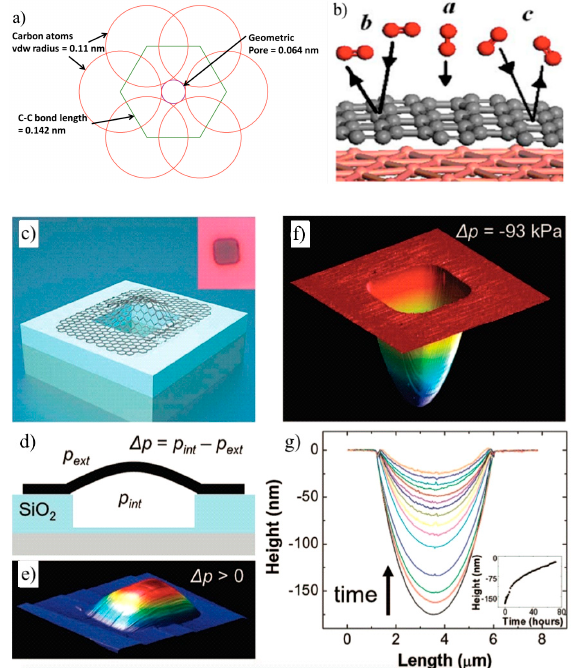
Figure 5. ( a ) Schematic diagram of the geometric pore size of graphene; ( b ) Simulation showing penetration attempt of oxygen molecule through graphene. The penetration energy barrier (PEB) is as follows: a. 34.3 eV, b. 40 eV and c. 38 eV; ( c ) schematic illustration of SiO 2 and graphene microchamber. (Inset) Optical image of real experimental setup; ( d ) Side view of the schematic microchamber image; ( e ) atomic force microscopy (AFM) (tapping mode) image of an expanded ∼ 9 nm thick graphene sheet with an upward deflection of 90 nm during Δ P > 0; ( f ) AFM image when Δ P = − 93 kPa creating a downward expansion (175 nm height); ( g ) AFM height measurement at different times (timespan 71.3 h) of the downward expanded graphene sheet during Δ P = − 93 kPa. The AFM measurement was performed along the center of the graphene membrane. (Inset) evolution of height with time. Reprinted with permission from ref. [22,83,87]. Copyright 2013, 2018, and 2008 Elsevier, David Publishing Company, and American Chemical Society respectively.